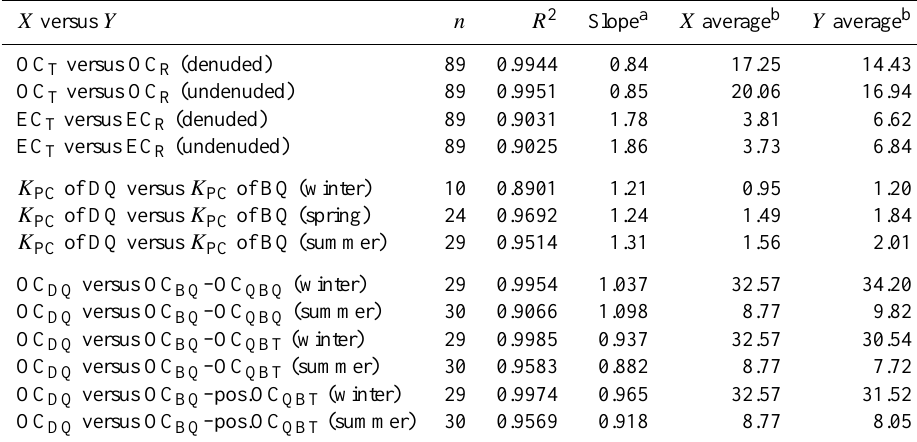
Table 2. Summary of the results from regression analysis. X versus Y n R 2 Slope a X average b Y average b OC T versus OC R (denuded) 89 0.9944 OC T versus OC R (undenuded) 89 EC T versus EC R (denuded) 89 K PC of DQ versus K PC of BQ (winter) K PC of DQ versus K PC of BQ